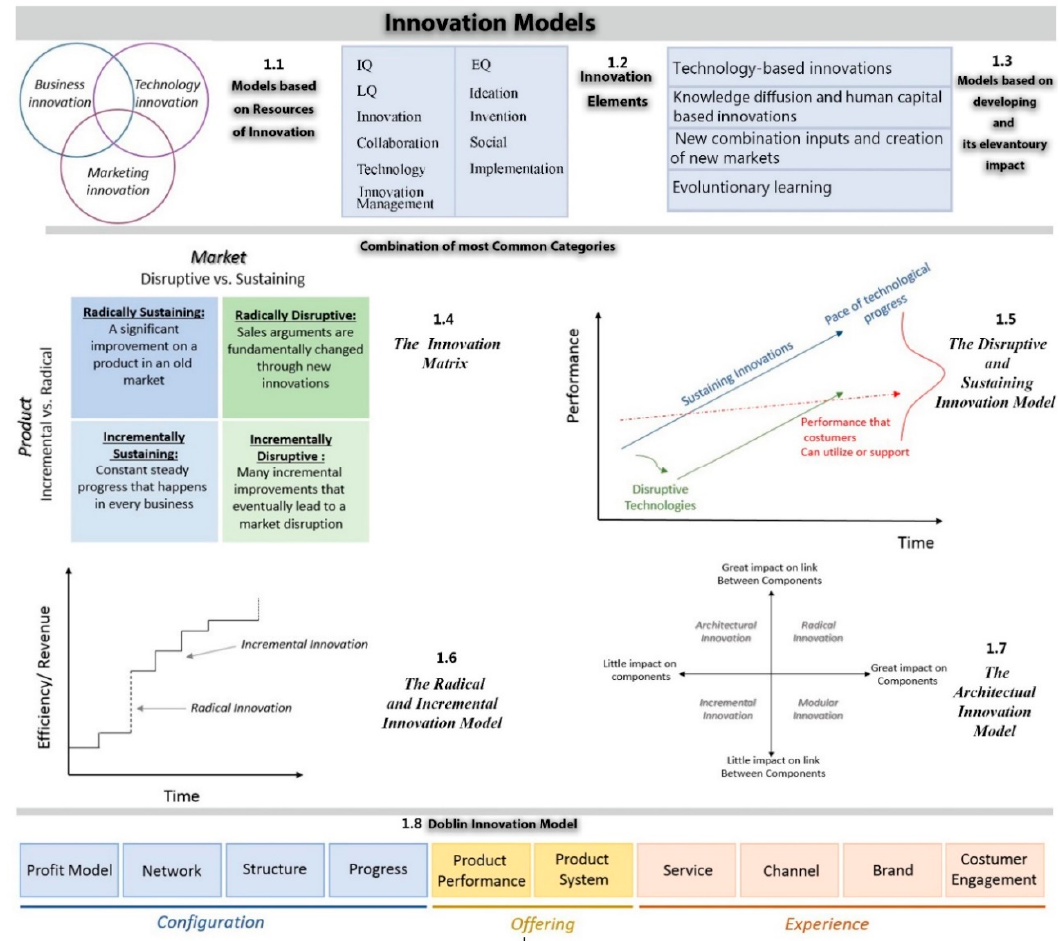
Figure 2. Innovation models (Adopted from References [8,25–28]).